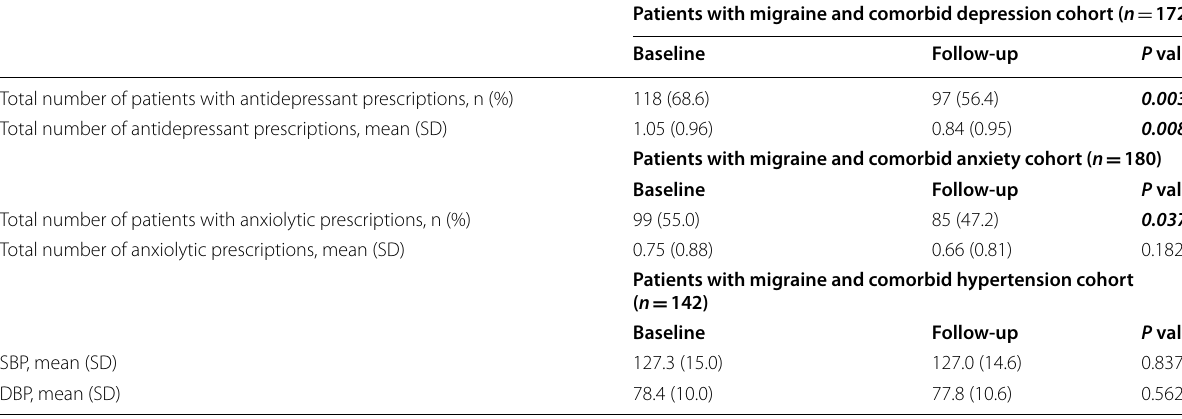
SD standard deviation, SBP systolic blood pressure, DBP diastolic blood pressure P values calculated via McNemar’s test and the paired t-test or Wilcoxon signed rank test to dichotomous and continuous variables, respectively; bold, italicized P values indicate statistical significance